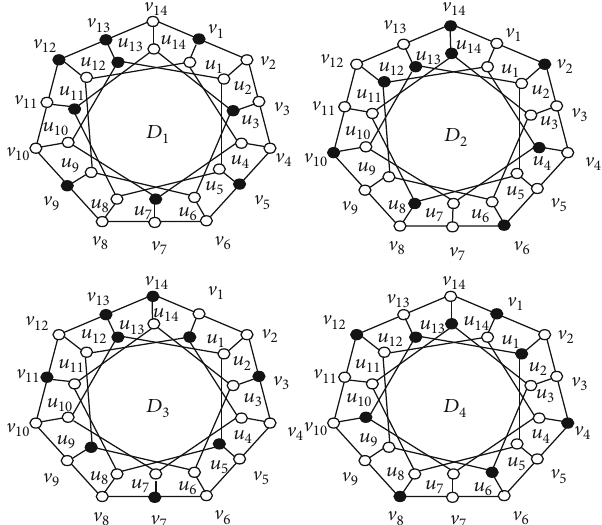
Figure 15: Eternally protecting P ð 14, 3 Þ with 9